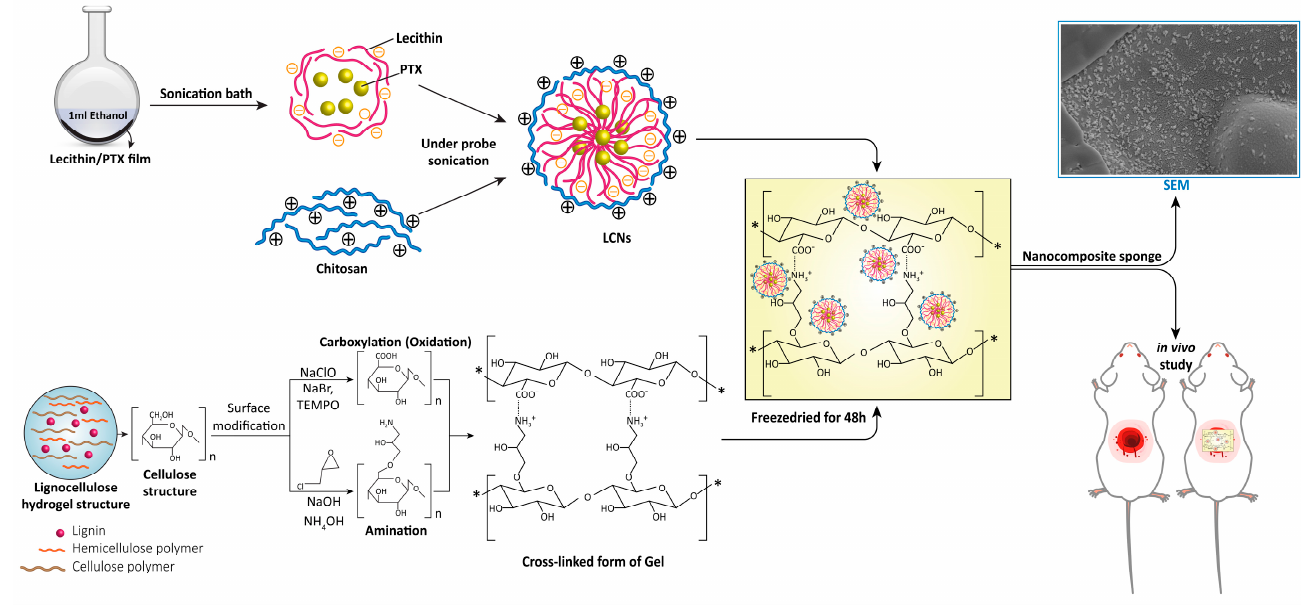
Figure 1. A schematic diagram representing the experimental design.